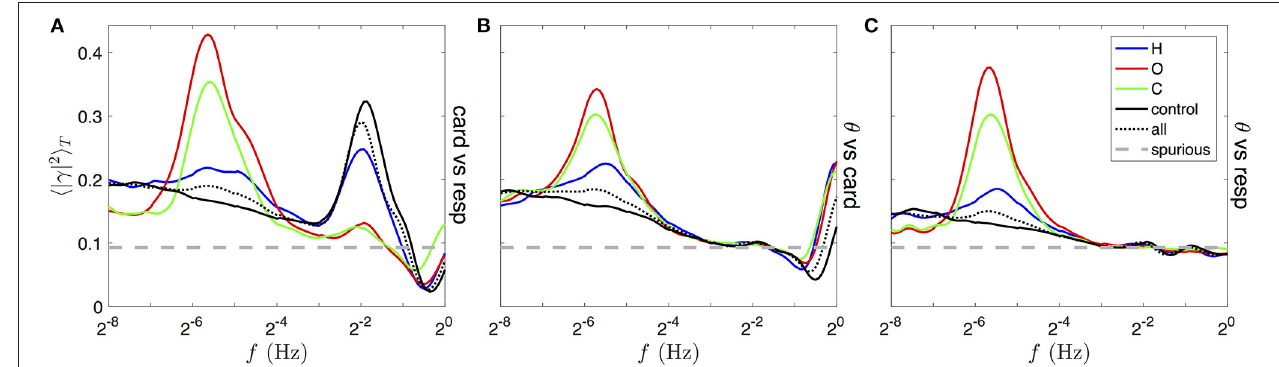
FIGURE 11 | Comparison of typical squared coherence profiles for different sleep apneas and from different rate signals pairs, obtained from the full database shhs2 . In each panel, colored lines are obtained by averaging the squared modulus of the time-frequency coherence, in distinct groups: 87 subjects strongly affected by hypopnea (blue lines), 153 by OSA (red lines) and 189 by CSA (green line). See text for details of the selection. The black line is the average over the full sleep duration of a control group very mildly affected by any type of apnea, the black dotted line is the unconditional average over the full sleep duration of all 2,650 subjects in the database, and the gray thick dashed line traces the expected level of spurious coherence. These profiles are mean squared coherences between (A) the cardiac vs. respiratory rate, (B) the θ band vs. the respiratory rate and (C) the θ band vs. the cardiac rate modulation signals, as shown for a single subject in Figures 10D,F,H before squaring and time